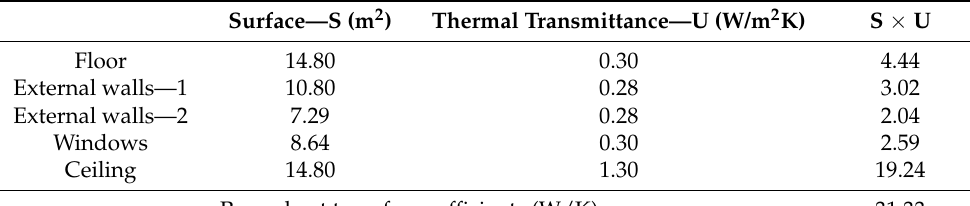
Figure 5. Typical plan test room. Table 1. Room heat transfer coefficients.